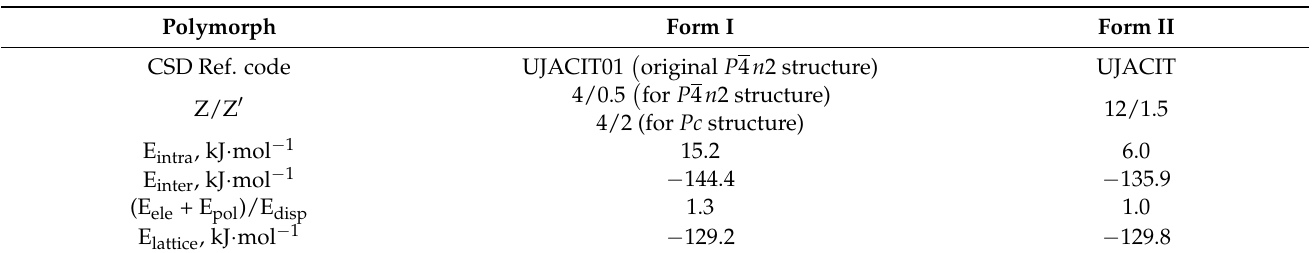
Table 2. Selected crystallographic data and the calculated intramolecular, intermolecular, and lattice energies of MPBA